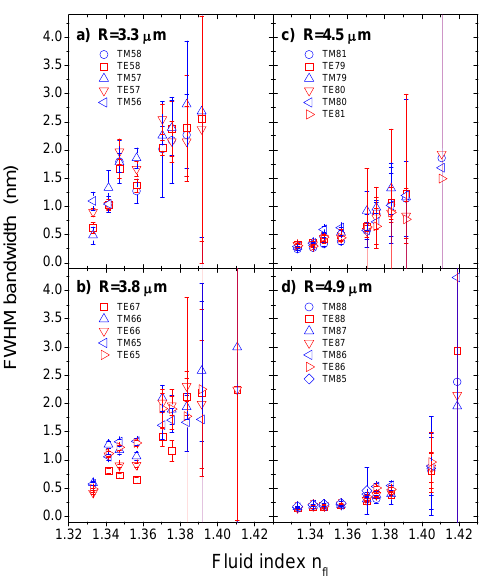
Figure 4. Full-width-half-maximum (FWHM) bandwidths of the WGMs of the four different beads shown in Figure 2 in dependence of the fluid index, n water/glycerol mixture injected into the microfluidic flow cell. The different modes are labeled according to their polarization, TM or TE, and mode number, errors shown are the variances calculated by the least mean square fitting